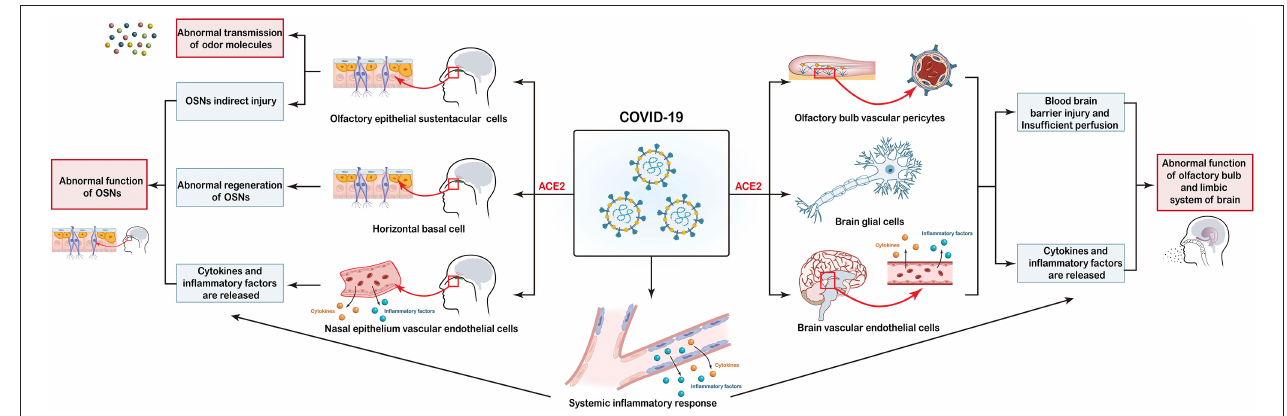
FIGURE 1 | Potential mechanisms of coronavirus disease 2019 (COVID-19)-induced olfactory dysfunction. (i) COVID-19 directly affects sustentacular (SUS) cells through interactions with the ACE2 receptor, thereby leading to abnormal transmission of odor molecules. (ii) Injury to SUS cells, horizontal basal cells (HBCs) as well as the release of cytokines and proinflammatory factors in the systemic and local nasal epithelium lead to abnormal function of olfactory sensory neurons (OSNs). (iii) Olfactory-bulb vascular pericytes, glial-cell injury, and release of cytokines and proinflammatory factors into the systemic and local brain trigger abnormalities in functions of the olfactory bulb and limbic system of the